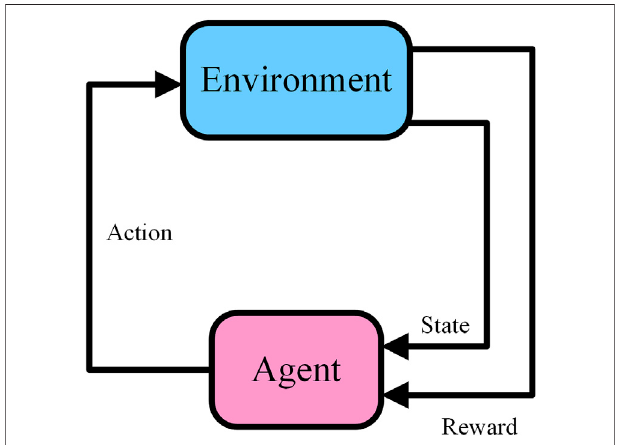
FIGURE 1 | Basic structure of reinforcement